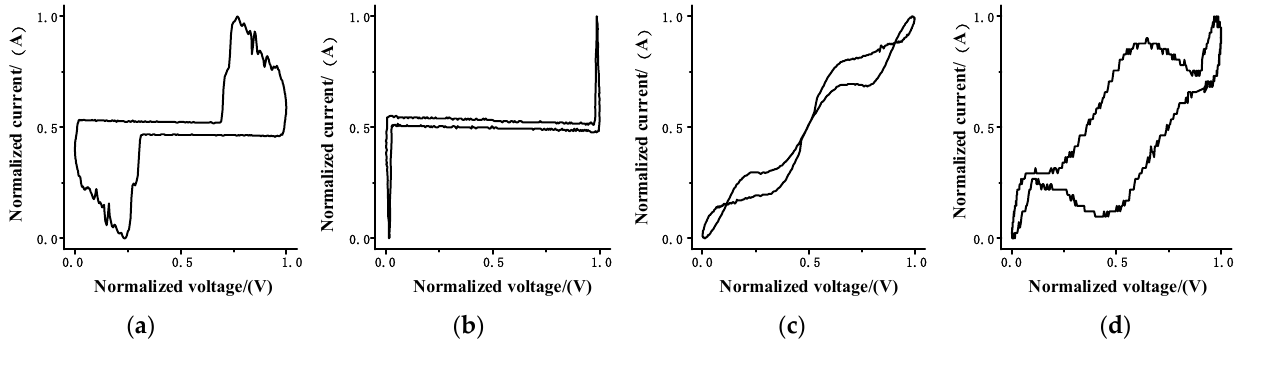
Figure 1. Typical load V-I trajectory diagram for ( a ) compact fluorescent lamp, ( b ) laptop, ( c ) fridge, ( d ) washing machine.